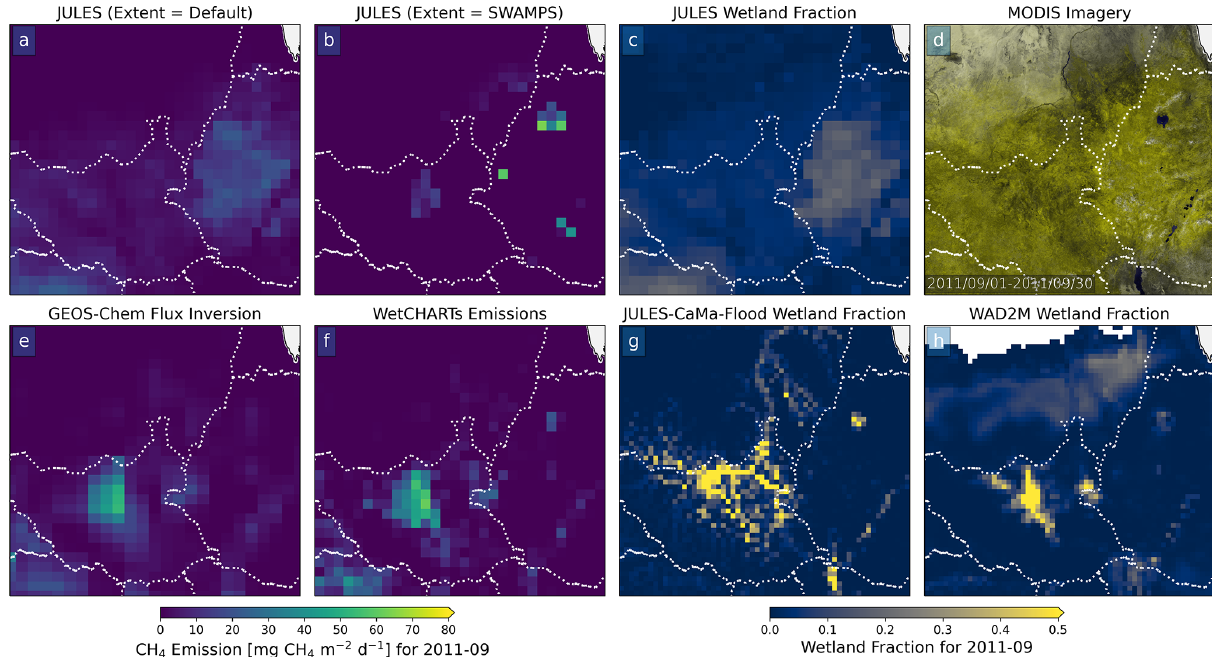
Figure 10. Comparison over the Sudd wetland region showing the wetland CH 4 emissions for September 2011 for (a) JULES with the default wetland extent, (b) JULES with the SWAMPS masking for wetland extent, (e) GEOS-Chem flux inversion of GOSAT XCH 4 over Africa and (f) the WetCHARTs ensemble mean. Also shown are the wetland fractions from (c) JULES, (g) JULES-CaMa-Flood and (h) WAD2M along with (d) MODIS (RGB) surface reflectance. Both JULES simulations are the configurations that use the WFDEI meteorological driving, the lower Q 10 value and phenological vegetation, as these were shown to provide the best result over this region (see Fig.